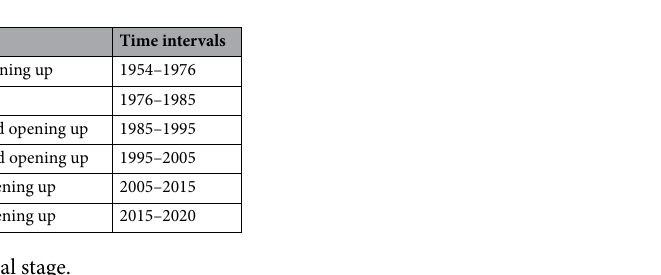
Table 3. Description of historical